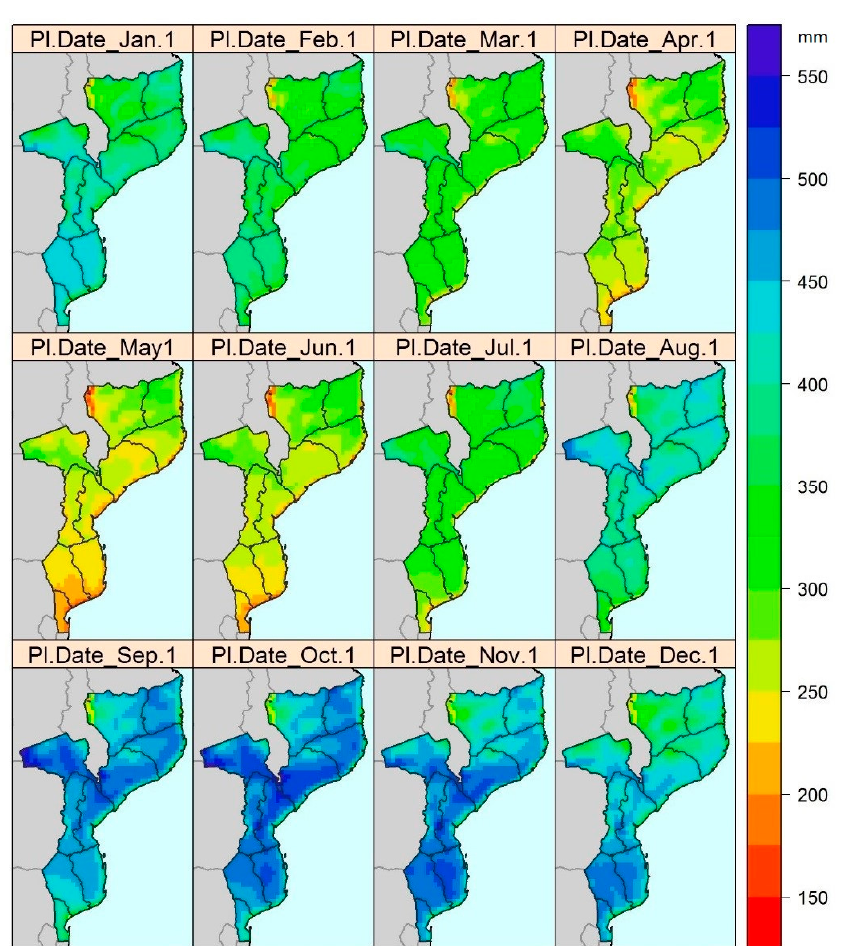
Figure 4. Spatial and temporal variability of tomato crop total water requirement (mm) for Mozambique for a generic variety with 90-day growing cycle planted in the first day of each month.